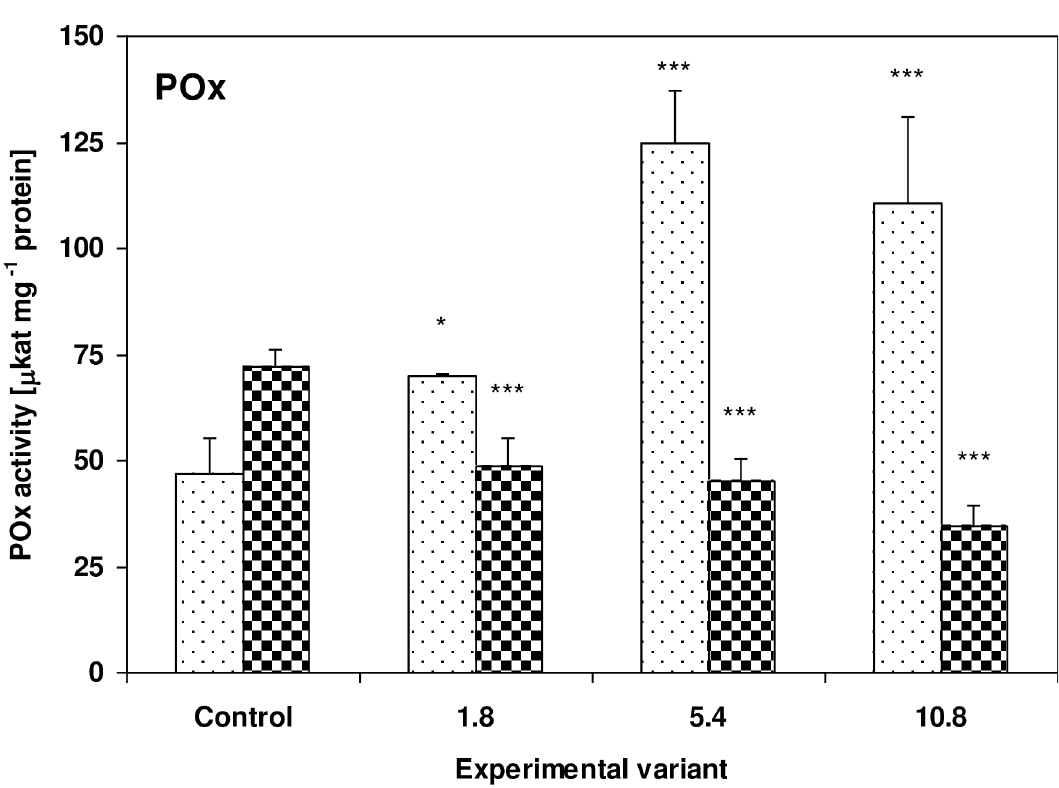
Fig 6. Activity of POx in the leaves of zucchini (square without filling) and cucumber (square with dots) grown on the control and sewage sludge amended soil. Activities are expressed in μ kat mg -1 protein. For further explanation, see Fig